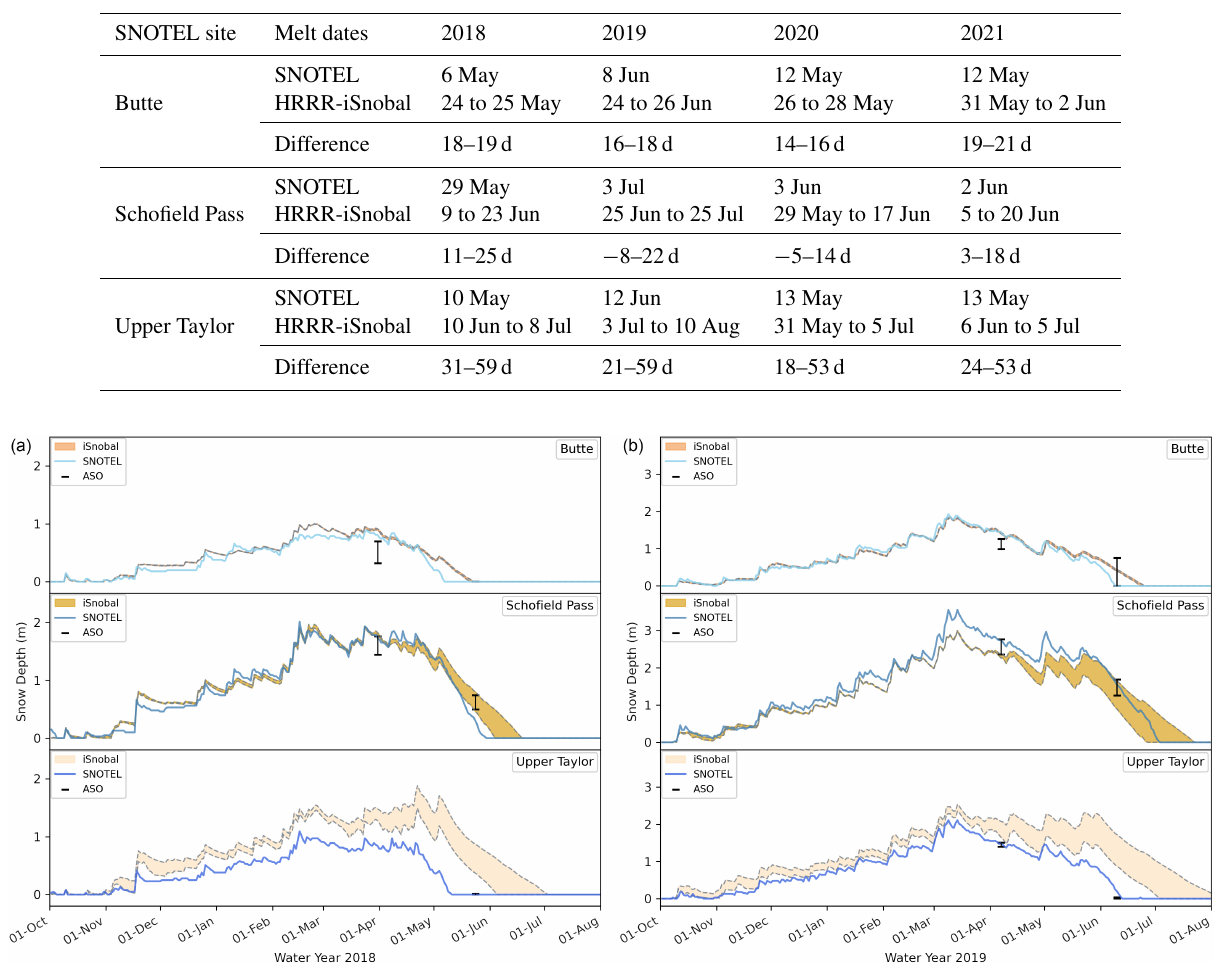
Figure 4. Snow depth comparison between the HRRR-iSnobal and SNOTEL sites for the years 2018 (a) and 2019 (b) . The orange-shaded areas represent the range of 2 × 2 grid cell values from HRRR-iSnobal surrounding the site. The ranges of the grid cell (50m) values from ASO surveys are shown by the black bars. Note the different y scales between 2018 and